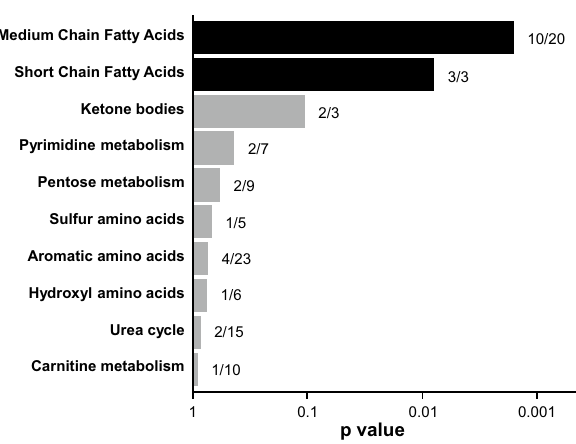
Figure 2. Enrichment of protective metabolites in select biochemical subclasses. The fraction of metabolites in each subclass that are protective is presented to the right of each bar. One-tailed Fisher’s exact test p values are shown following their logarithmic base 10 transformation (x-axis). Blue bars mark metabolite subclasses that are significantly enriched. The top ten subclasses are